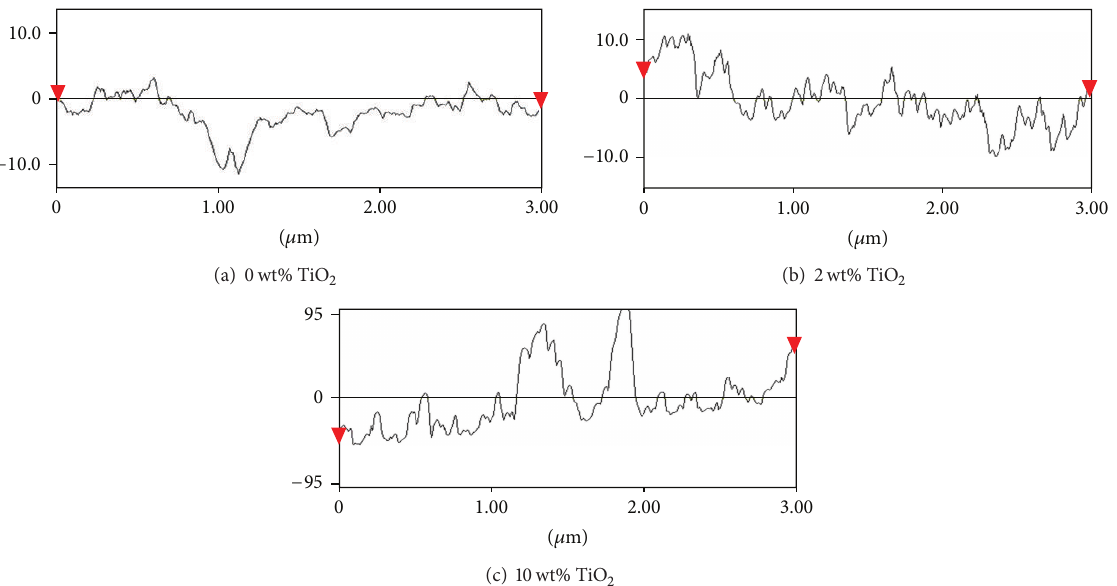
Figure 2: AFM analysis for different wt% of TiO 2 on the PES membrane.